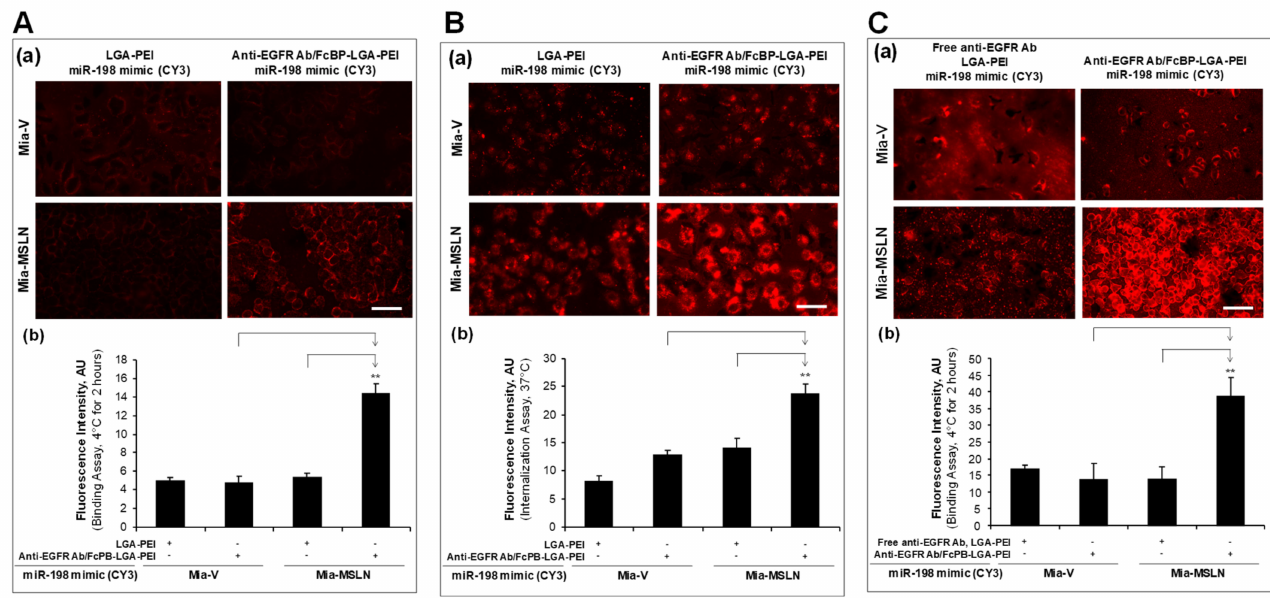
Figure 5. Targeting delivery of anti-EGFR Ab/FcBP-LGA-PEI nanoparticles (NPs) with nucleic acids to specific cells in vitro. ( A ) Cell binding assay of anti-EGFR Ab/FcBP-LGA-PEI/miR-198 mimics NPs and LGA-PEI/miR-198 mimics NPs. Fluorescence (Cy3)-labeled anti-EGFR Ab/FcBP-LGA-PEI/miR-198 mimics NPs or LGA-PEI/miR-198 mimics